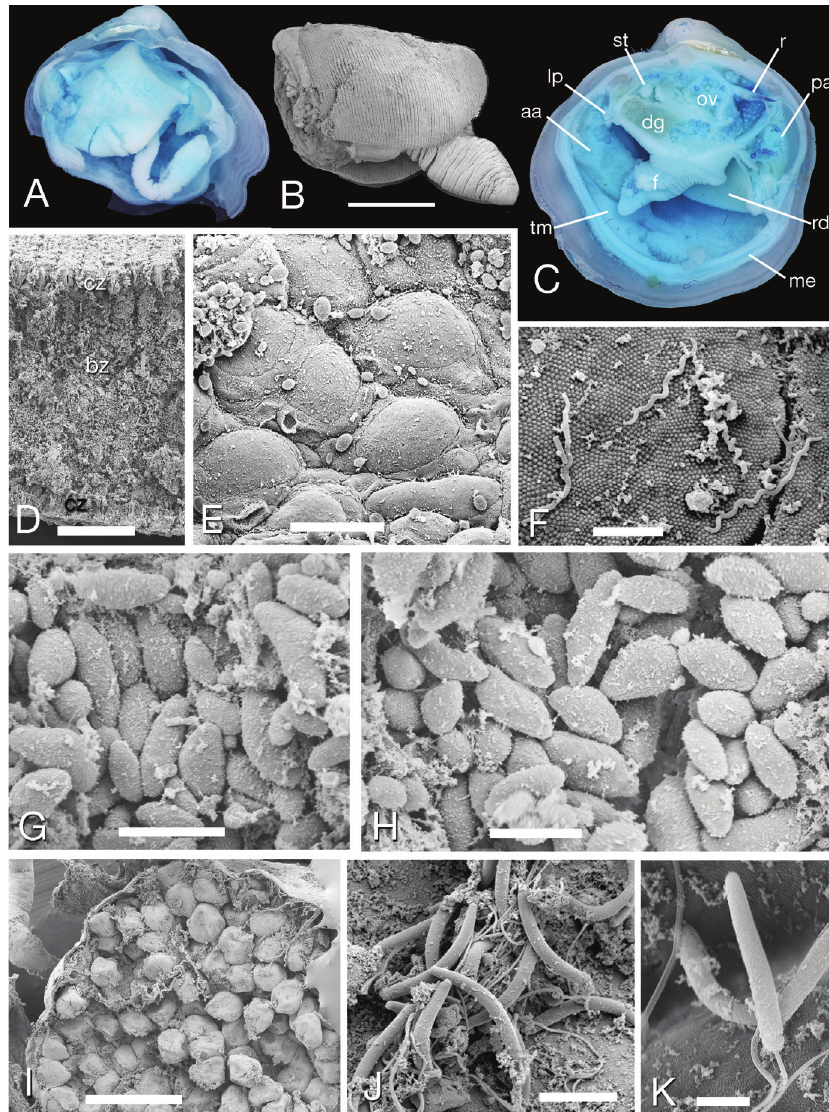
Figure 3. Pleurolucina harperae , general anatomy, ctenidia, bacteria, oocytes and sperm. A Right side, with mantle removed, right demibranch and extended foot stained with methylene blue L 7 mm B Left demibranch and foot, critical point dried preparation. Scale bar = 1 mm C Cut section to show general anatomy, stained with methylene blue L 8 mm D Transverse section through single ctenidial demibranch. Scale bar = 100 µm E Surface of bacteriocytes and intercalary cells on lateral view of a ctenidial filament. Scale bar = 15 µm F Spirochaete bacteria on surface of bacteriocytes. Scale bar = 2 µm G , H Symbiotic bacteria contained in bacteriocyte. Scale bar = 5 µm I Developing oocytes. Scale bar = 500 µm J , K Sperm. Scale bars = 5, 2 µm respectively. aa anterior adductor muscle bz bacteriocyte zone cz ciliated zone dg di- gestive gland f foot lp labial palps me mantle edge ov ovary with oocyctes pa posterior adductor r rectum rd right demibranch st stomach tm thickened mantle ventral to anterior adductor